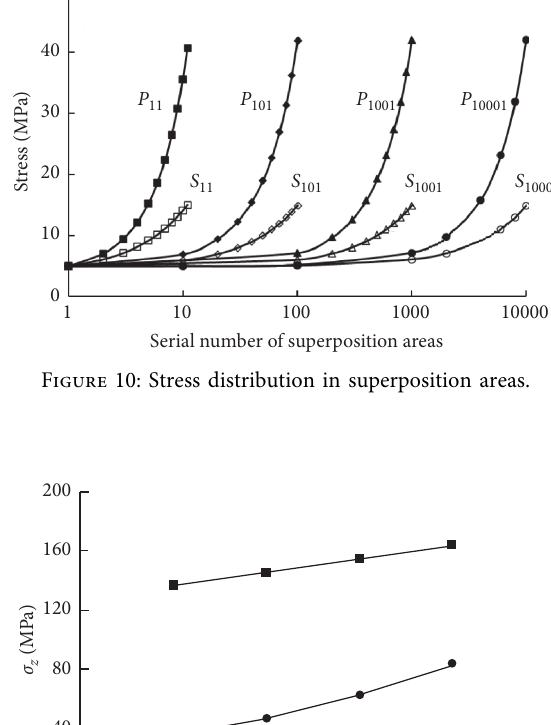
Figure 8: Solving flow.